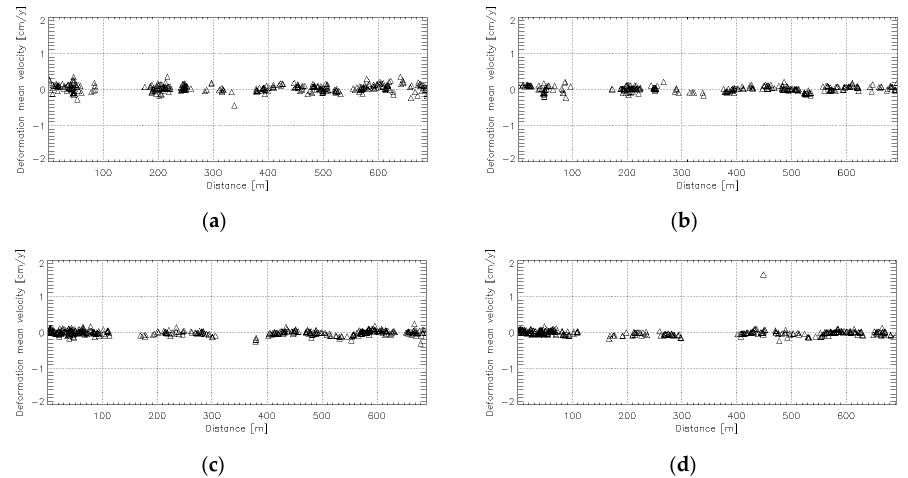
Figure 6. Plots of the estimated deformation mean velocity of the coherent pixels located at the northern roadway level within the yellow rectangle in Figure 4 for the ( a ) SBAS and ( b ) TomoSAR processing results achieved for the ascending dataset, and ( c ) SBAS and ( d ) TomoSAR results relevant to the descending dataset. Horizontal axis corresponds to the longitudinal distance from the origin of the yellow rectangle located at its southern/eastern end, as reported by the white graduated scale in Figure 4.